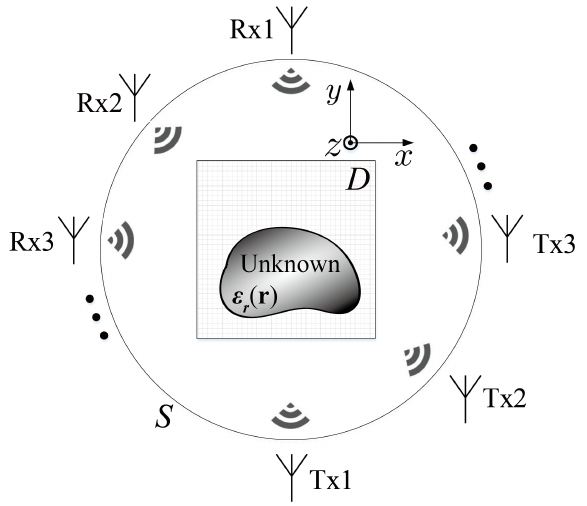
Figure 1. Configuration of ISPs with homogeneous